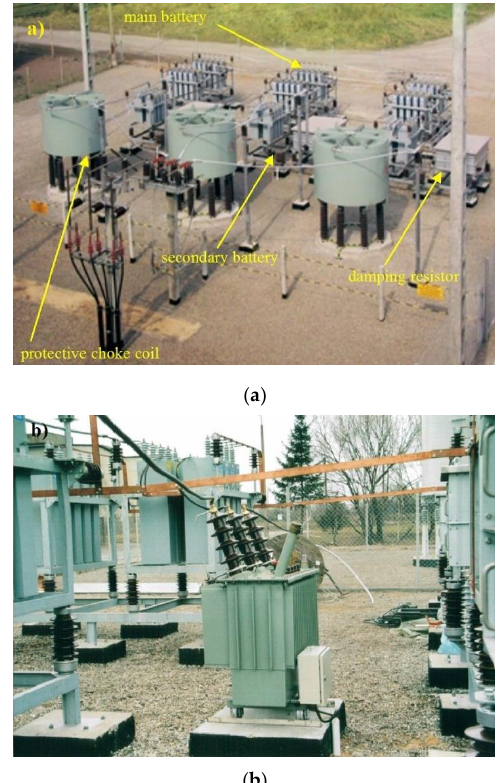
Figure 9. Real view of the designed system. ( a ) C-type filter. ( b ) 63 kVA/30 kV transformer for fast discharge of the main capacitor bank of a C-type second harmonic filter.